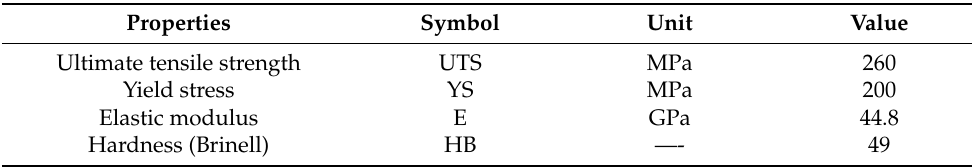
Table 4. Mechanical properties of AZ31 magnesium alloy